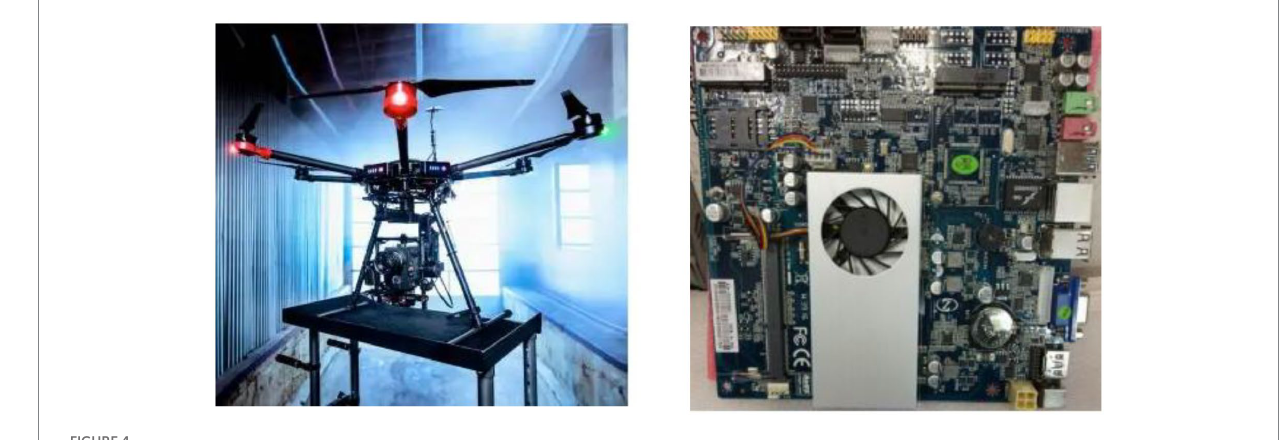
FIGURE 4 Test flight platform.